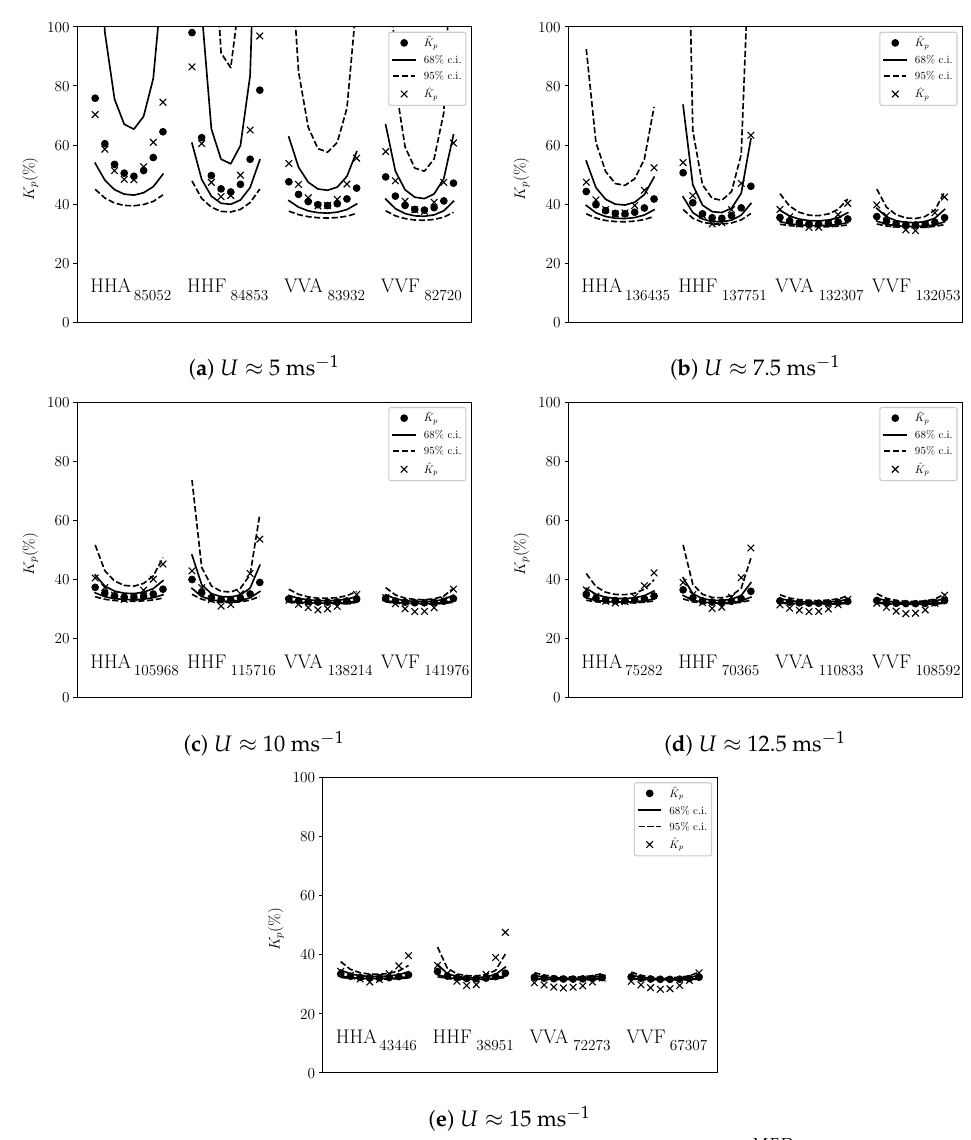
Figure 4. In each plot, the circles represent the median of product K p s ( K MED p ) as a function of the slice index, for each of the four flavors (pol; view) , and for the σ 0 level corresponding approximately to the wind speed indicated in the caption. The 68% (95%) confidence intervals of K p are represented with solid (dashed) lines. Estimates of K p from data ( K EMP p ) are depicted with crosses. The total number of samples is reported by the flavor string, which is composed in the following way: HH (VV) stands for HH-Pol (VV-Pol) and A (F) stands for aft